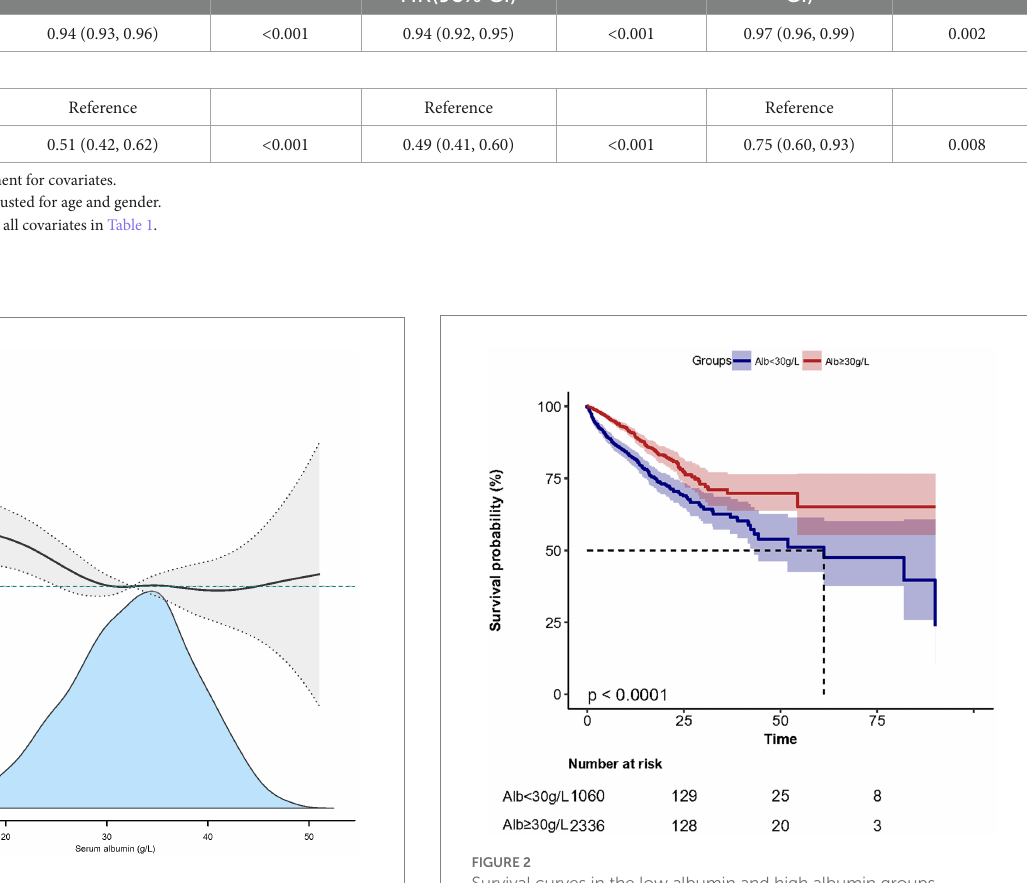
FIGURE 1 Nonlinear relationship between serum albumin and in-hospital mortality (adjusted all covariates in Table 1).